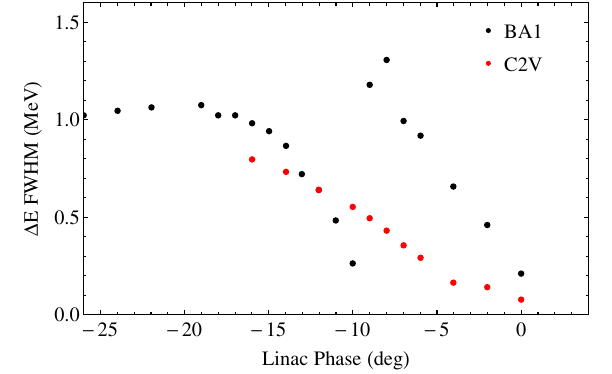
FIG. 40. CTR signal dependence on the linac off-crest phase. Measurements were made in